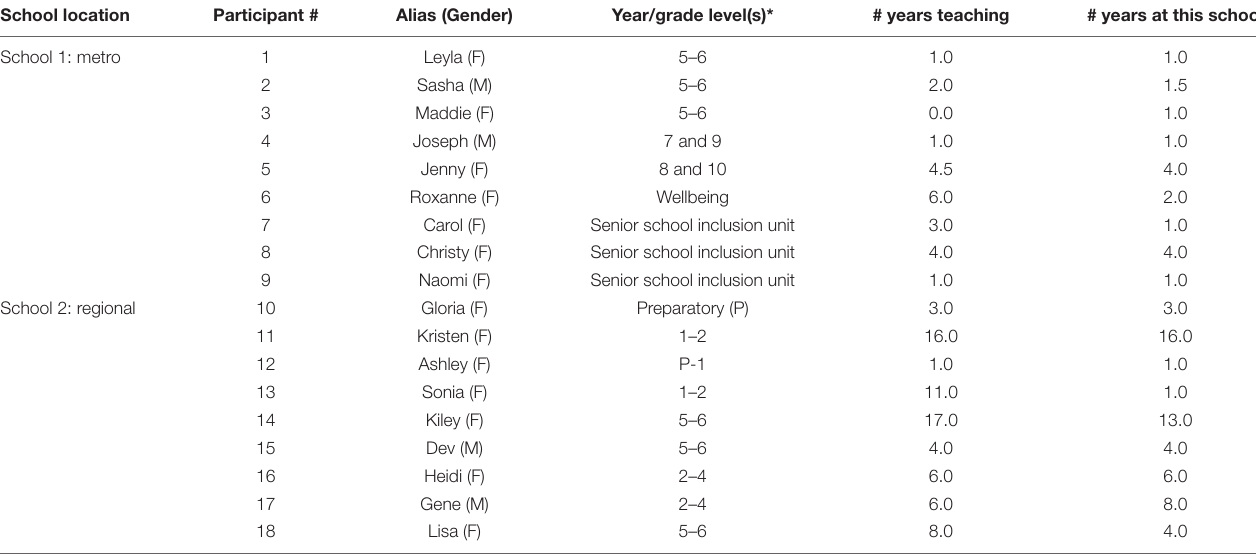
TABLE 1 | Demographic information for participating